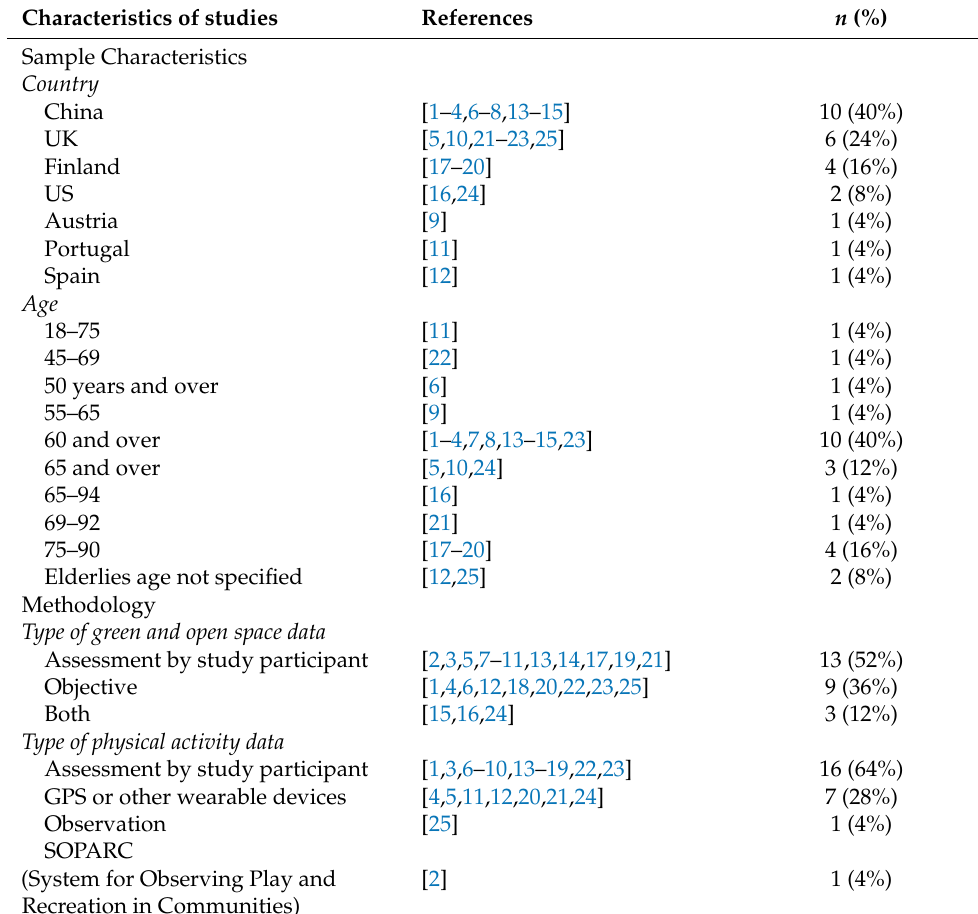
Table 1. Study characteristics of the included articles ( n =